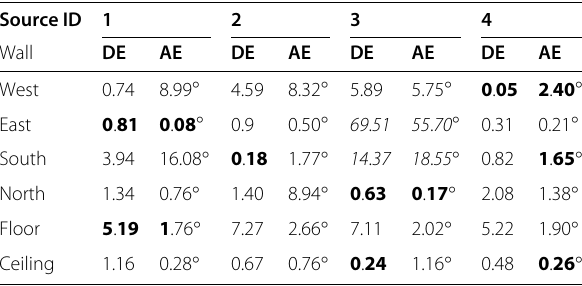
Table 7 Distance error (DE) in centimeters and angular error (AE) in degrees between ground truth and estimated room facets using each of the sound sources (#1 to #4) as a probe Source ID 1